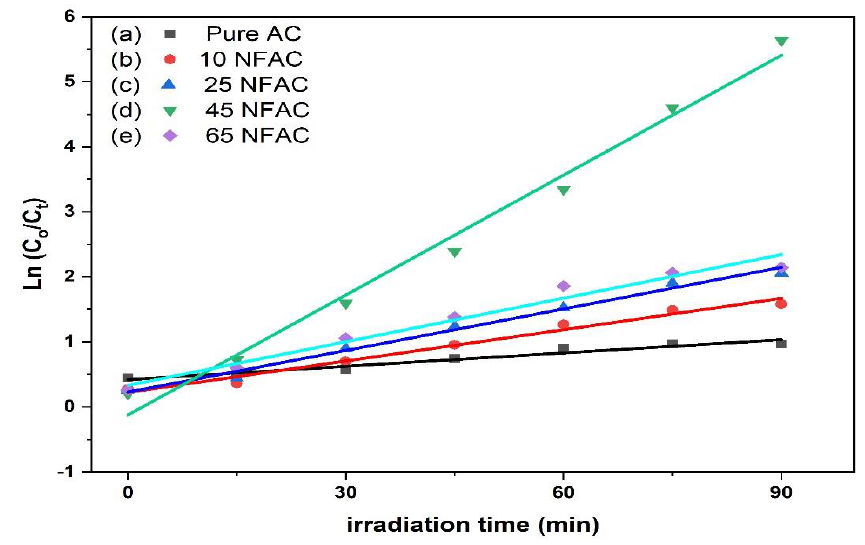
Figure 11. The pseudo first-order kinetic of photocatalytic degradation of rhodamine B over pure and modified activated carbon.